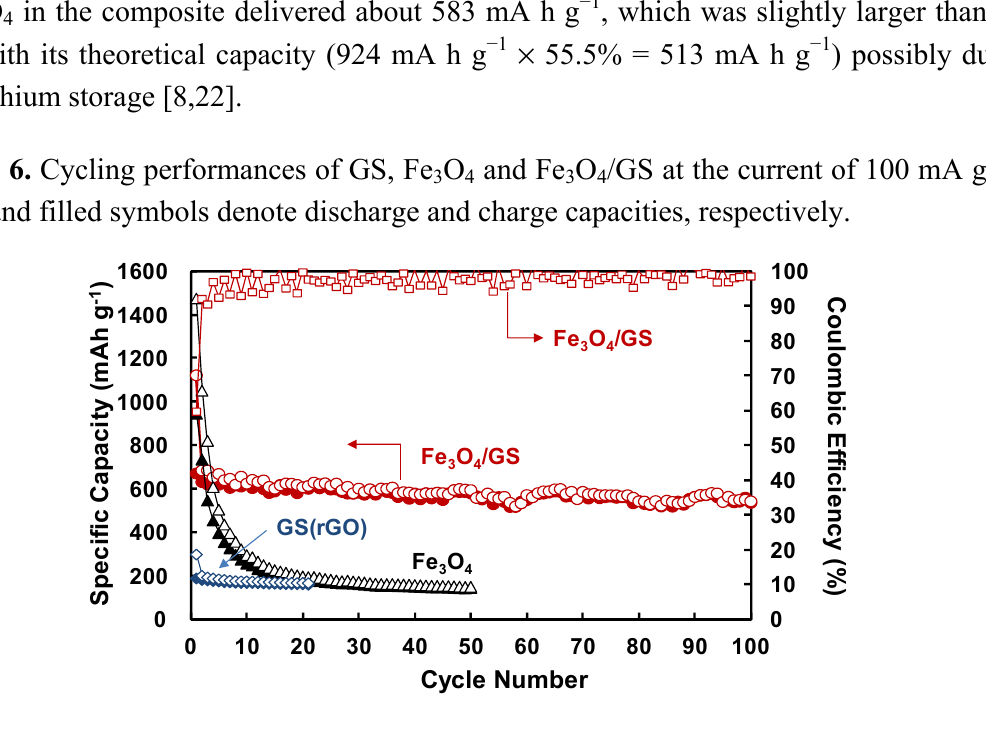
O and Fe O /GS at the current of 100 mA g − 1 . 3 4 3 4